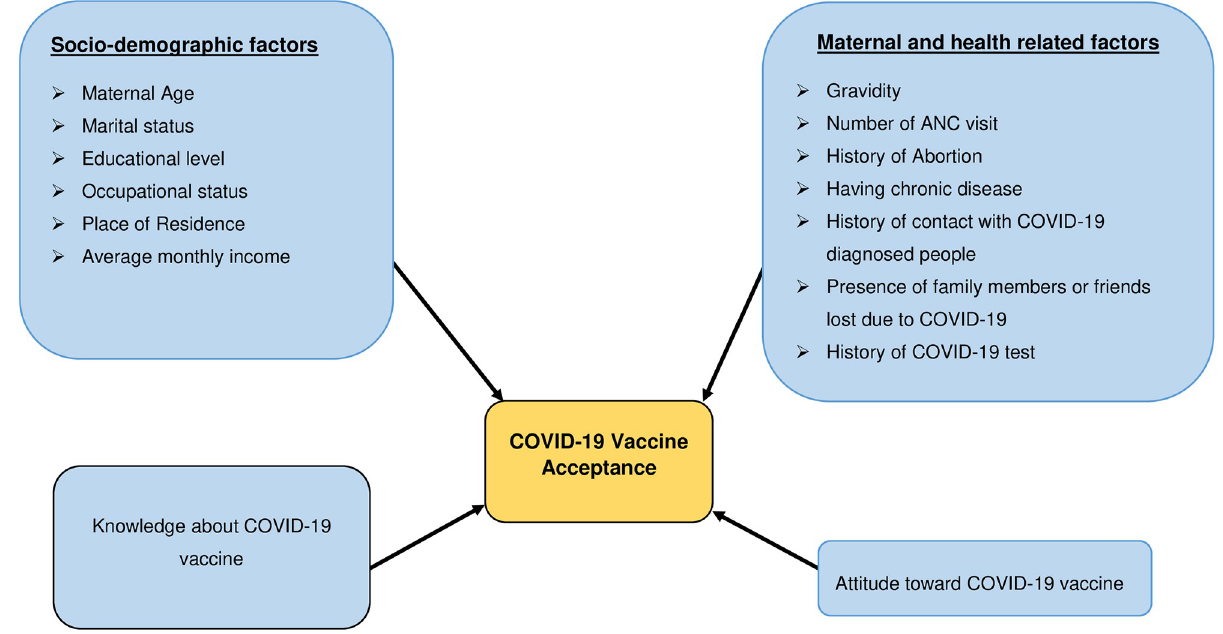
Fig 1. A conceptual framework for COVID-19 vaccine acceptance and associated factors among pregnant women at Gondar town, Northwest Ethiopia, 2021.